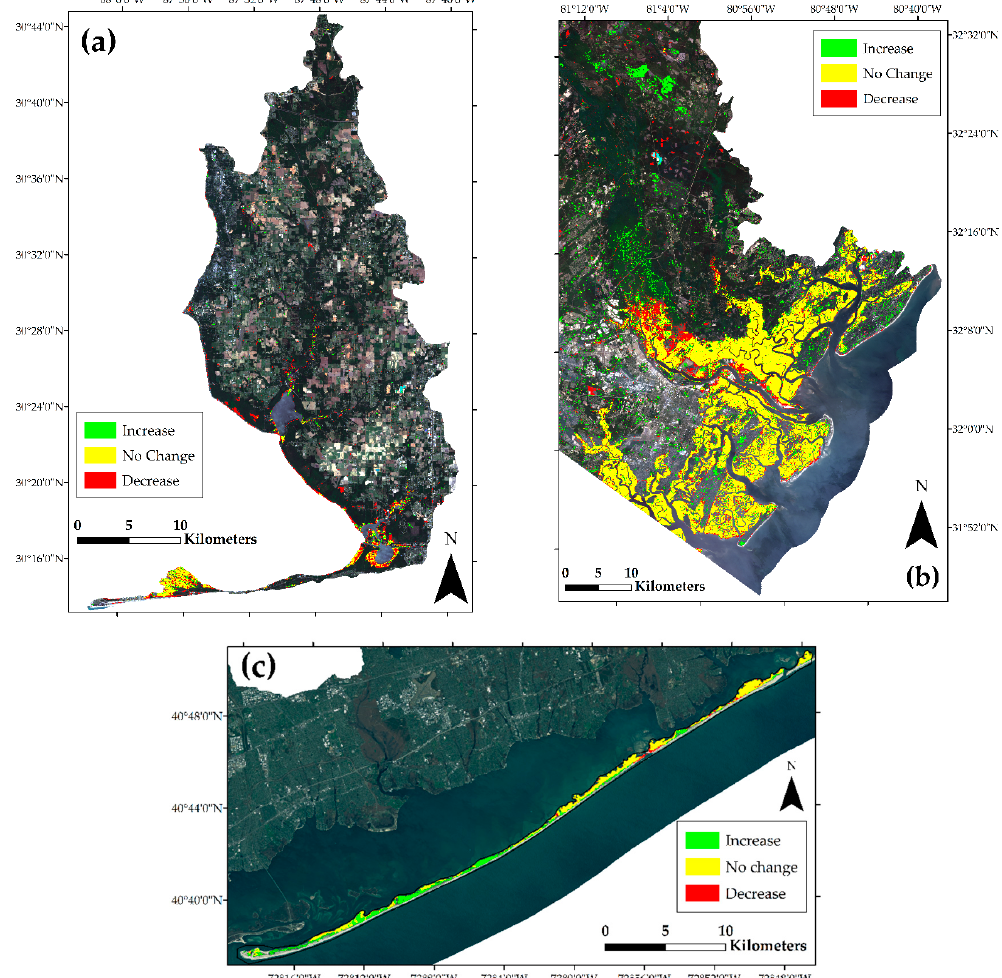
Figure 3. Emergent herbaceous wetland change detection in ( a ) Weeks Bay, Alabama; ( b ) Savannah Estuary, Georgia; and ( c ) Fire Island, New York based on the 2016 NLCD and 2019 imagery dataset. Color code indicates regions where this land cover class has emerged / migrated to upland areas (green), not changed (yellow) and vanished (red).